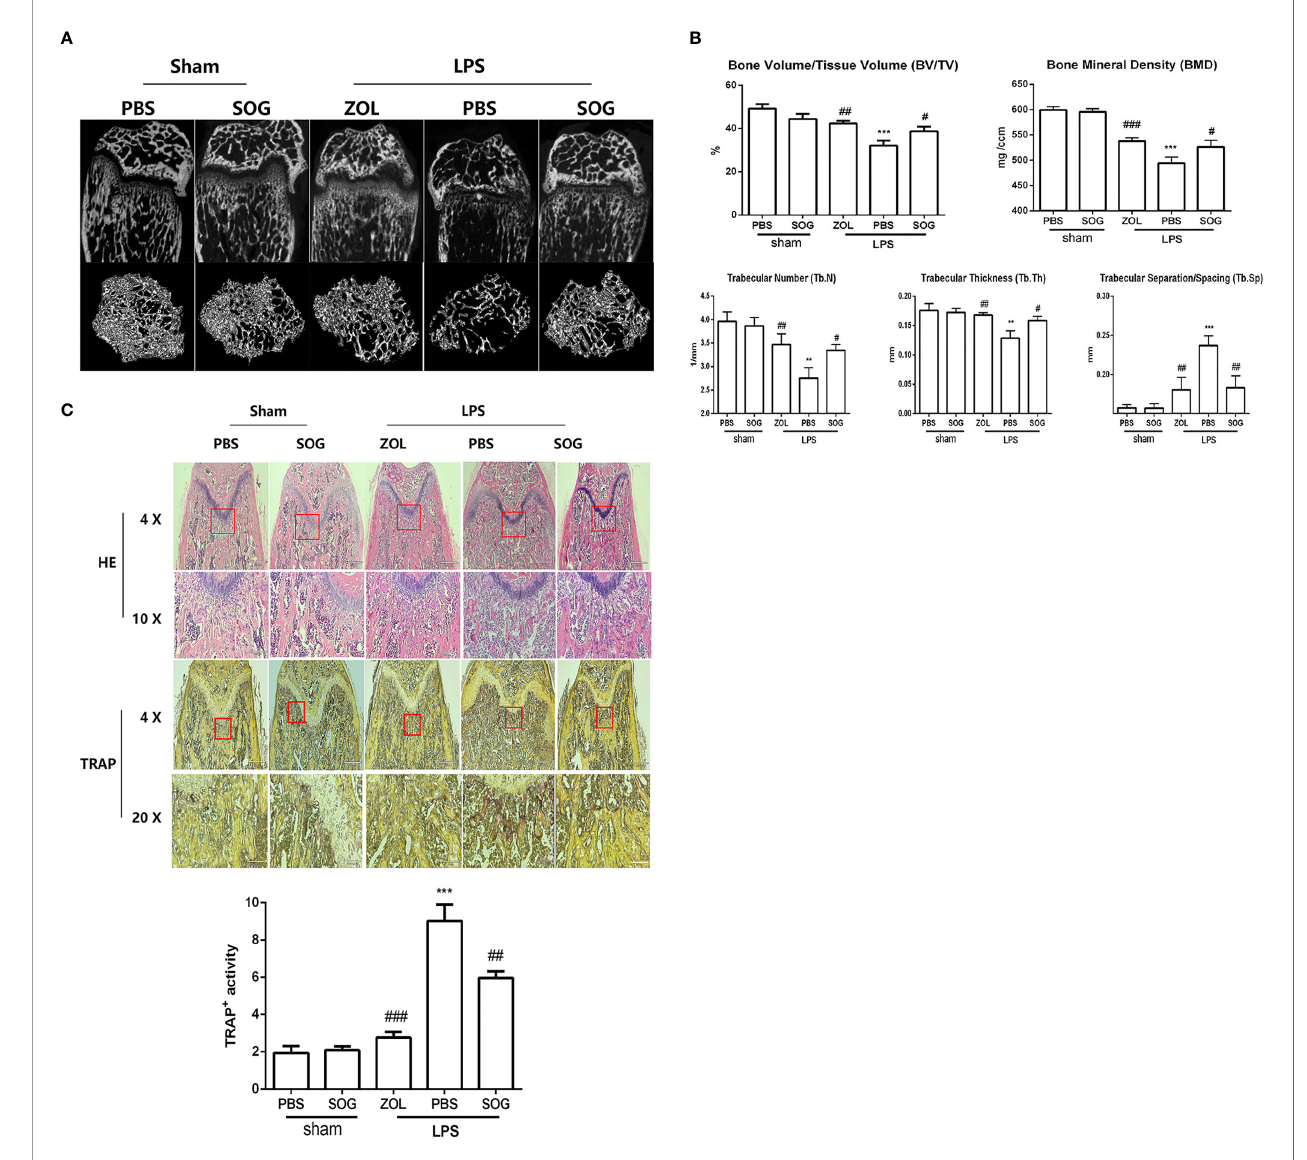
FIGURE 7 | SOG improved LPS-induced bone loss in mice. (A) Representative 2D and 3D reconstructions of micro-CT scans of femurs. (B) Bone volume/Tissue Volume (BV/TV), Bone mineral density (BMD), trabecular number (Tb.N), trabecular separation/spacing (Tb.Sp), and trabecular thickness (Tb.Th) of femurs were quanti fi ed by micro-CT data analysis using CT analyzer software. (C) Histological sections of femoral bone tissue sections stained with H&E (at 40× and 100× magni fi cation), TRAP staining (at 40× and 200× magni fi cation) and quanti fi cation of TRAP staining. Data are expressed as means ± SD. * p < 0.05, ** p < 0.01, and *** p < 0.001 versus sham group; # p < 0.05, ## p < 0.01, and ### p < 0.001 versus LPS